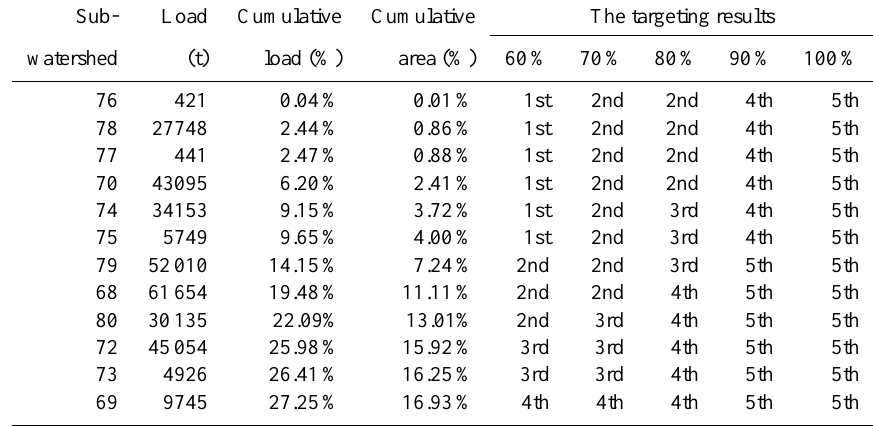
Table 2. The targeting results based on the MAP-PMAs in the Daning watershed. Sub- Load Cumulative